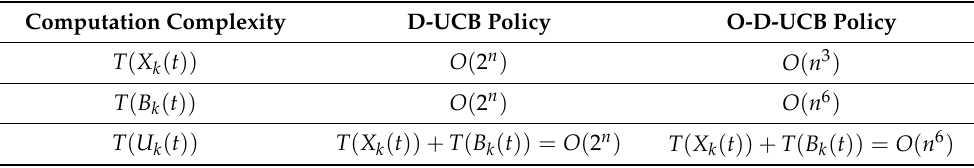
Table 5. The computation complexity of D-UCB policy and O-D-UCB